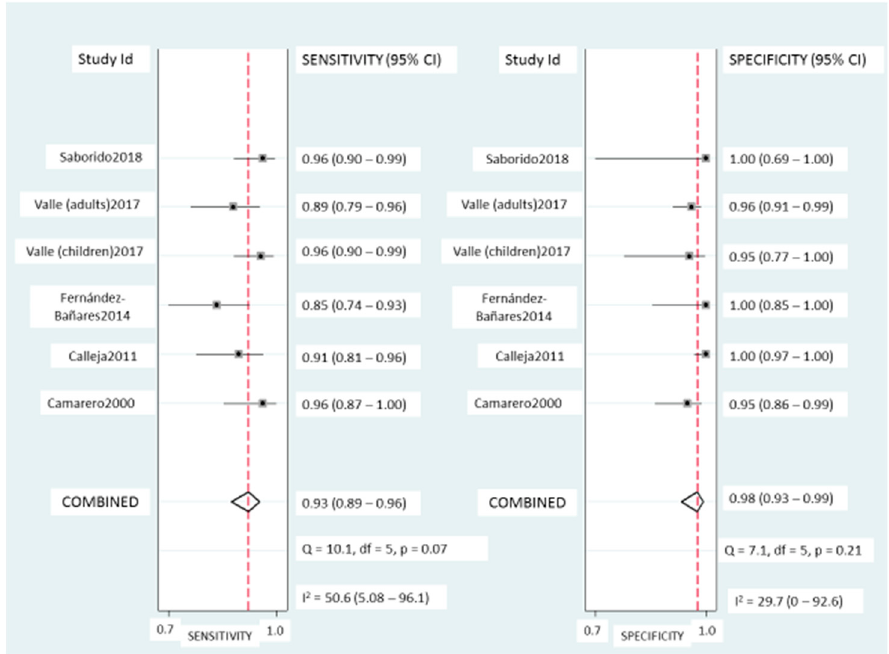
Figure 2. Forest plots showing the pooled sensitivity and specificity of coeliac lymphogram (defined as an increase in TCR γδ + IEL plus a decrease in CD3 − IEL) for coeliac disease diagnos.